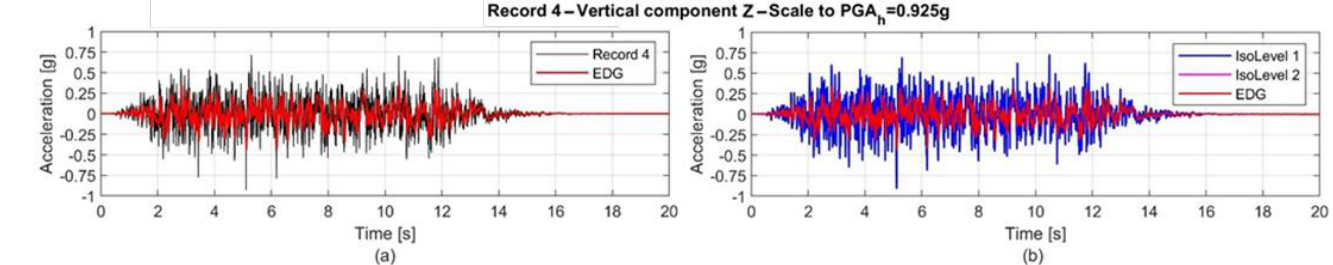
Figure 8. Vertical acceleration time history results for Record 4 with PGA = 0.925 g—direction “Z”. ( a ) Record and EDG response comparison; ( b ) System response by isolation level.